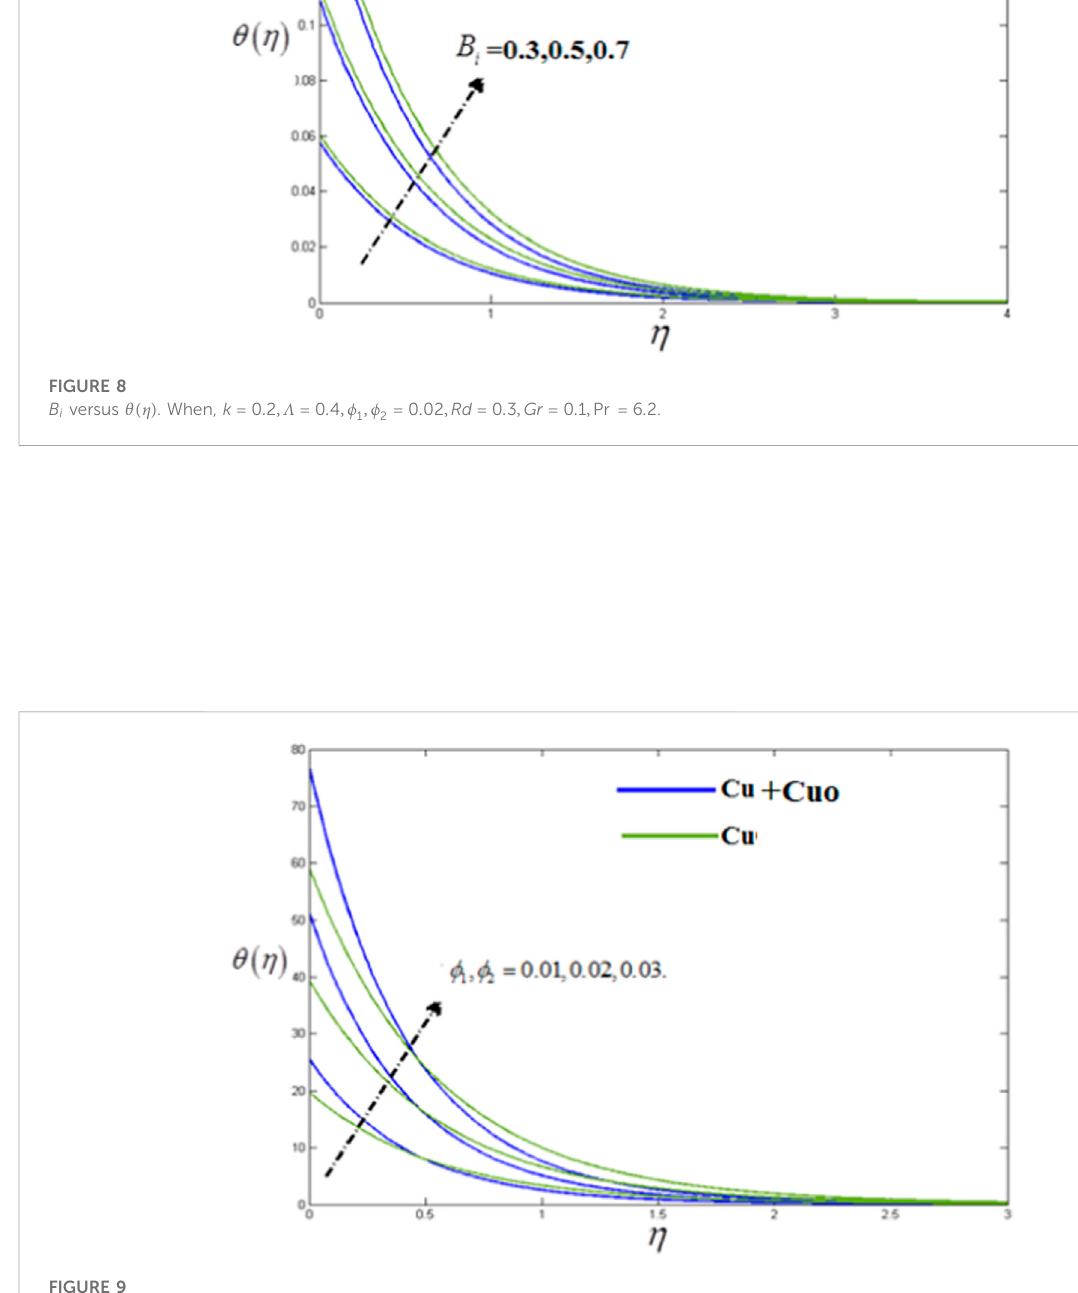
(cid:2) 0 . 2 , Rd (cid:2) 0 . 3 , Gr (cid:2) 0 . 1 , Pr (cid:2) 6 . i